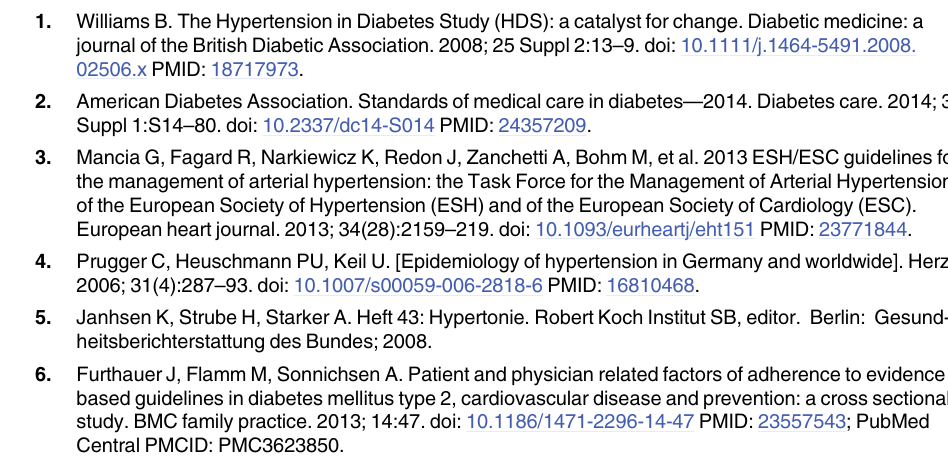
S1 Fig. Flowchart. S2 Fig. Frequencies of controlled treated, uncontrolled, known but untreated and unknown hypertension in participants without, with prevalent and with incident T2D in the baseline and follow-up examinations. Hypertension was defined as blood pressure (cid:1) 140/90 mmHg, N = 5,939, weighted dataset. S3 Fig. Percentages of participants with uncontrolled blood pressure (cid:1) 140/90 mmHg and concomitant pulse pressure values (cid:1) 60 mmHg, stratified by T2D and age groups in the fol- low-up examinations. S1 Table. Blood pressure parameters at baseline and follow-up, stratified by T2D status. Numbers are weighted and given as means with 95% CI in brackets , (cid:4) SBP: Systolic blood pres- sure. (cid:4)(cid:4) DBP: Diastolic blood pressure. (cid:4)(cid:4)(cid:4) PP: Pulse pressure. ● BL: Baseline. ●● FUP: